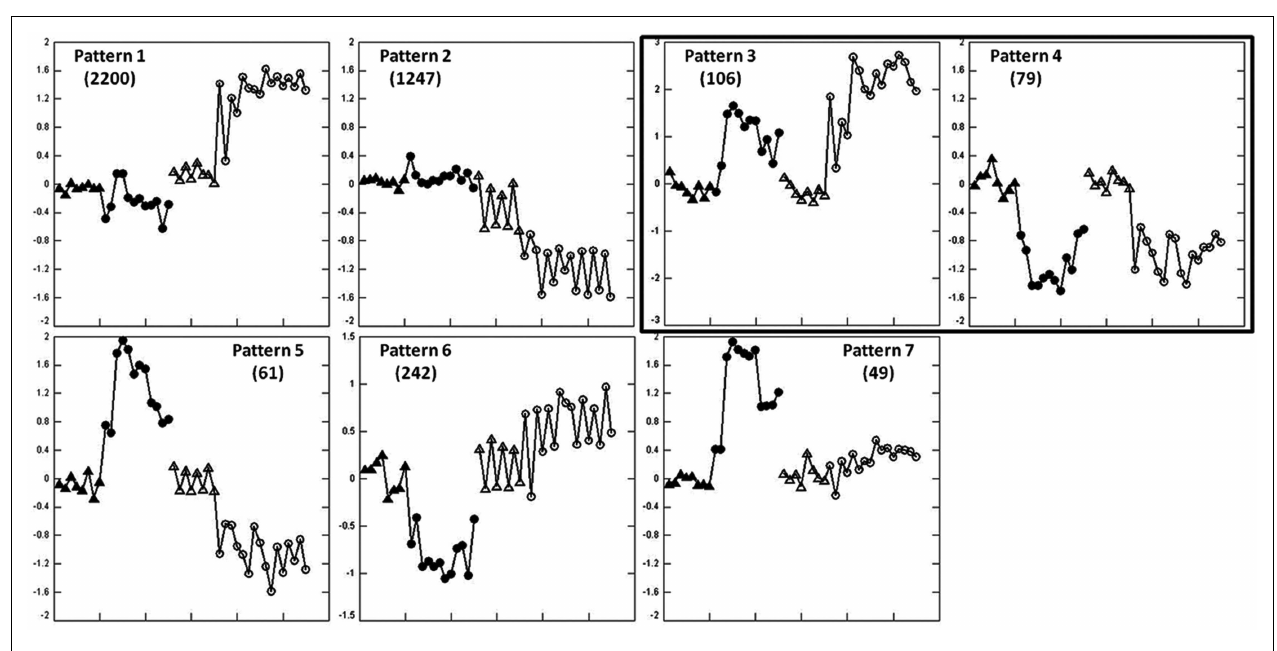
those in Figure 1A . Gene numbers for each pattern are shown in parentheses. Patterns 3 and 4 contained genes undergo similar regulation in liver and